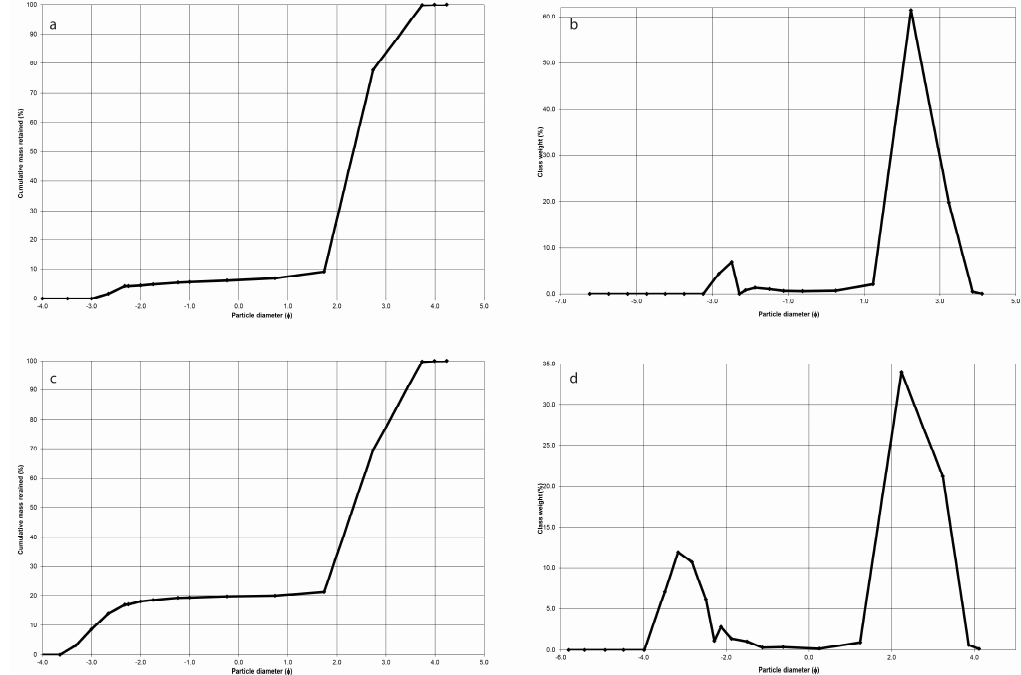
Figure 6. Cumulative (phi) and Distribution (phi) curves. ( a , b ) sample AK1/SD. ( c , d ) sample AK11/SD.